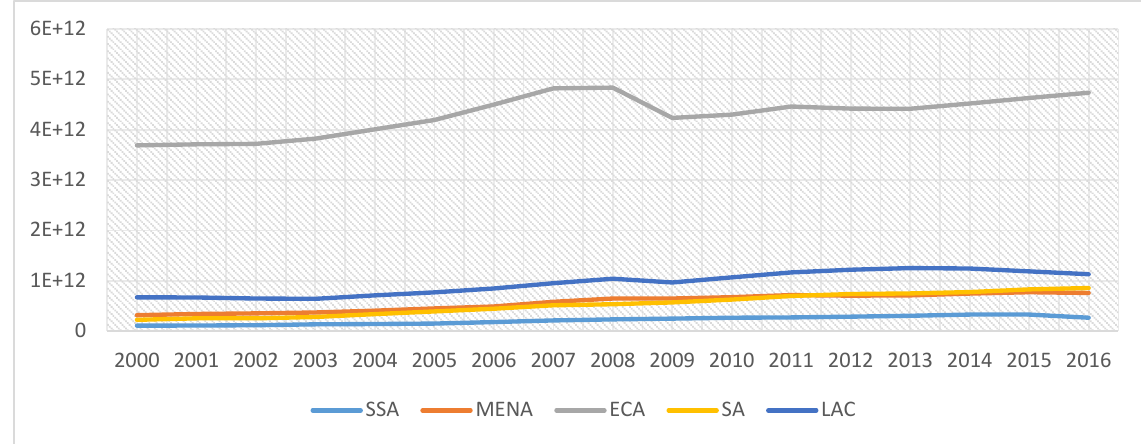
Figure 1.1 . Gross Fixed Capital Formation, Constant US$